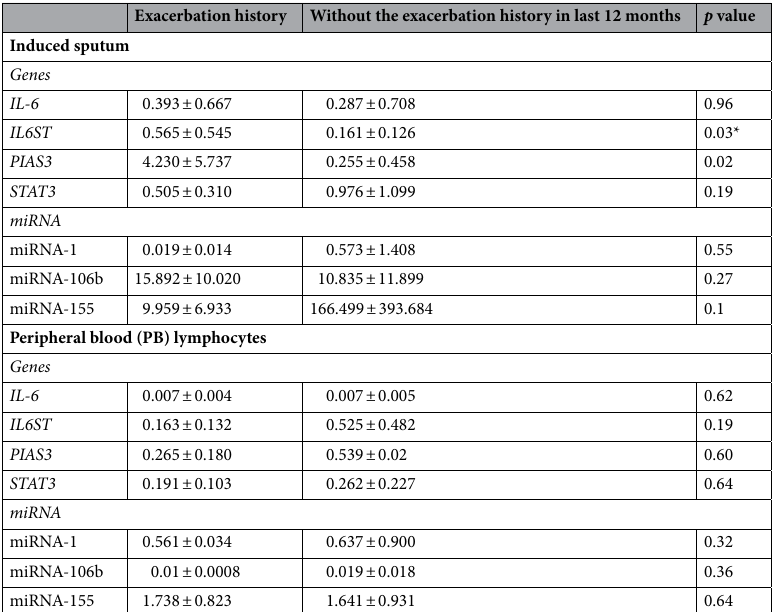
Table 4. The expression levels (mean RQ value) of the studied genes and miRNAs in COPD patients with/ without the exacerbation